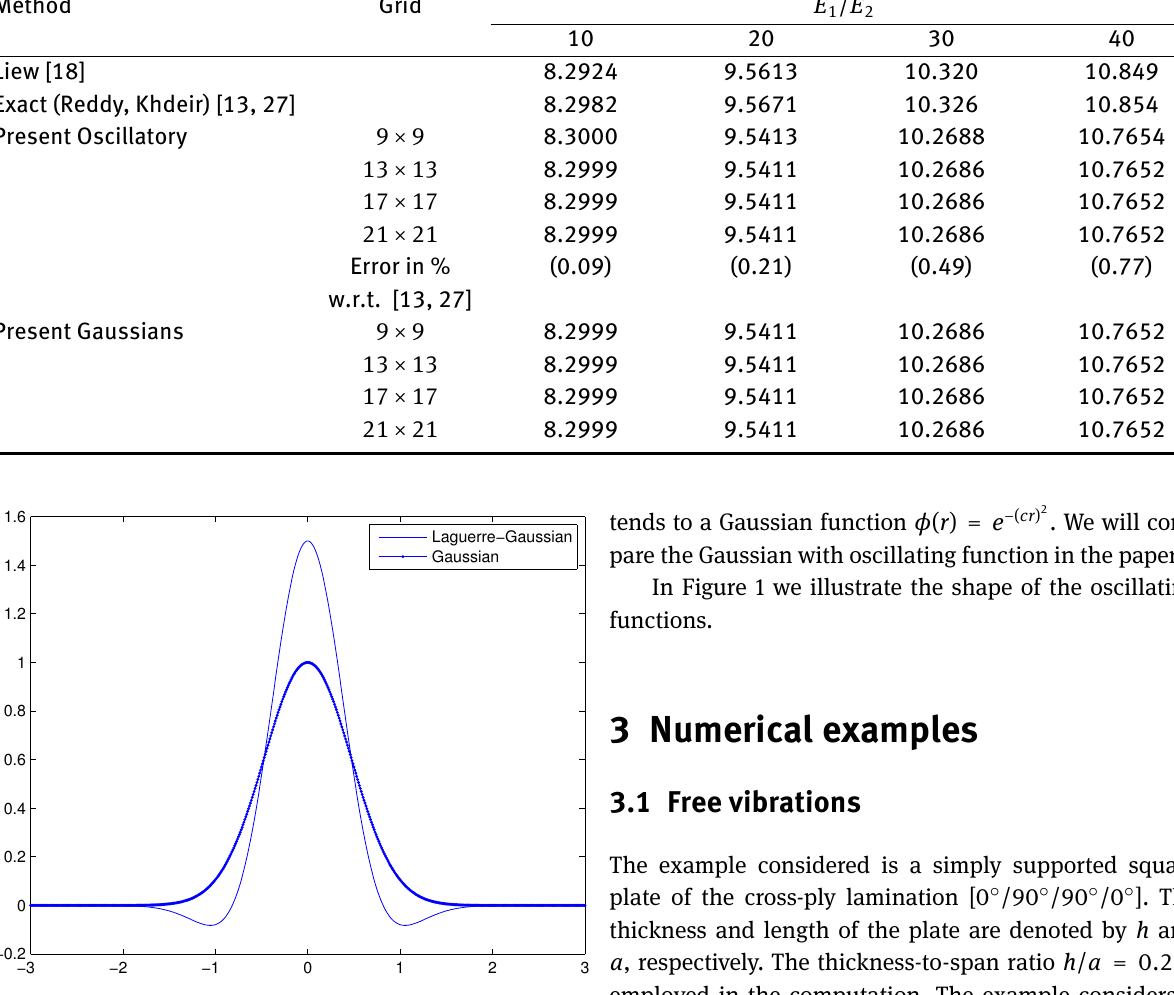
Figure 1: Oscillating and Gaussian functions